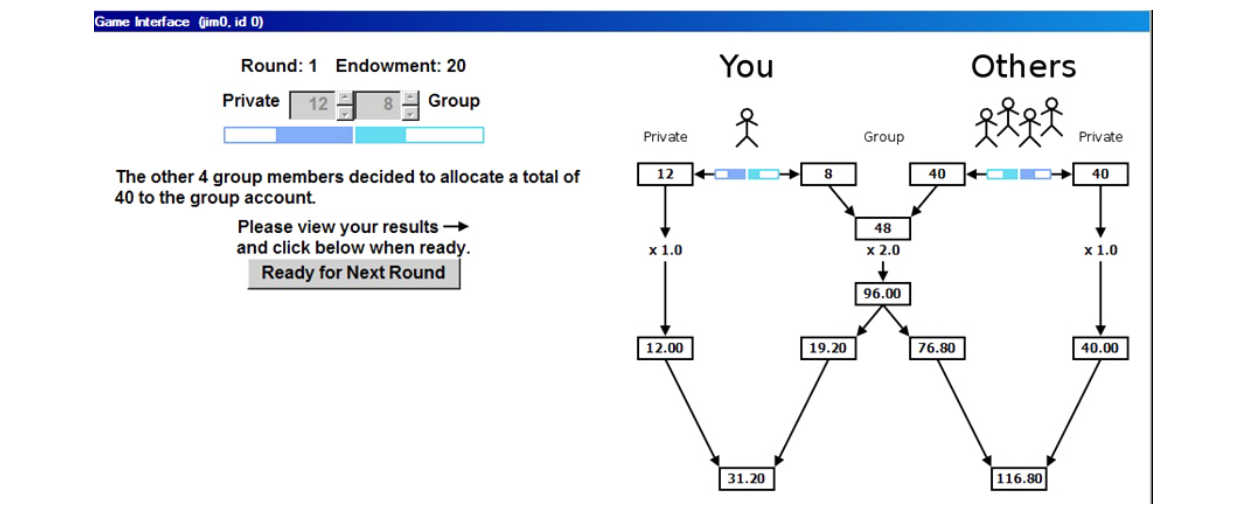
Fig. 1 . Example of the subject interface for the Baseline